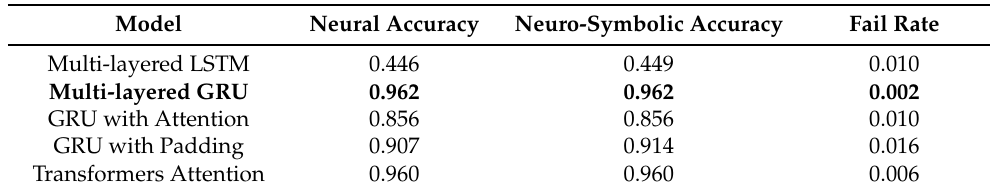
Table 2. Neuro-symbolic reasoning evaluation.